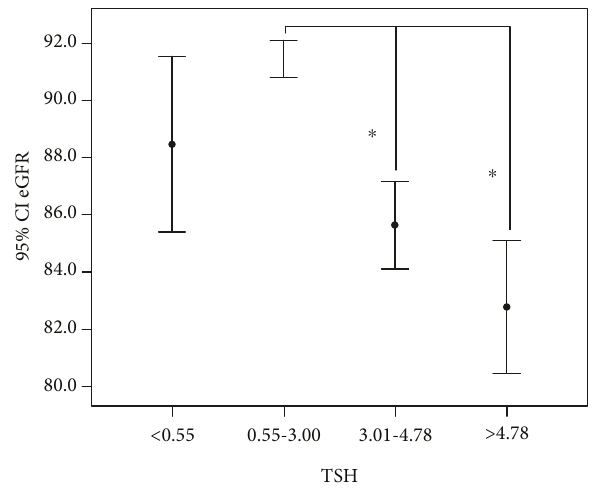
Figure 4: The mean and 95% CI of eGFR in 5936 participants in type 2 diabetes without overt thyroid dysfunction according to di ff erent TSH levels. ∗ p < 0 05